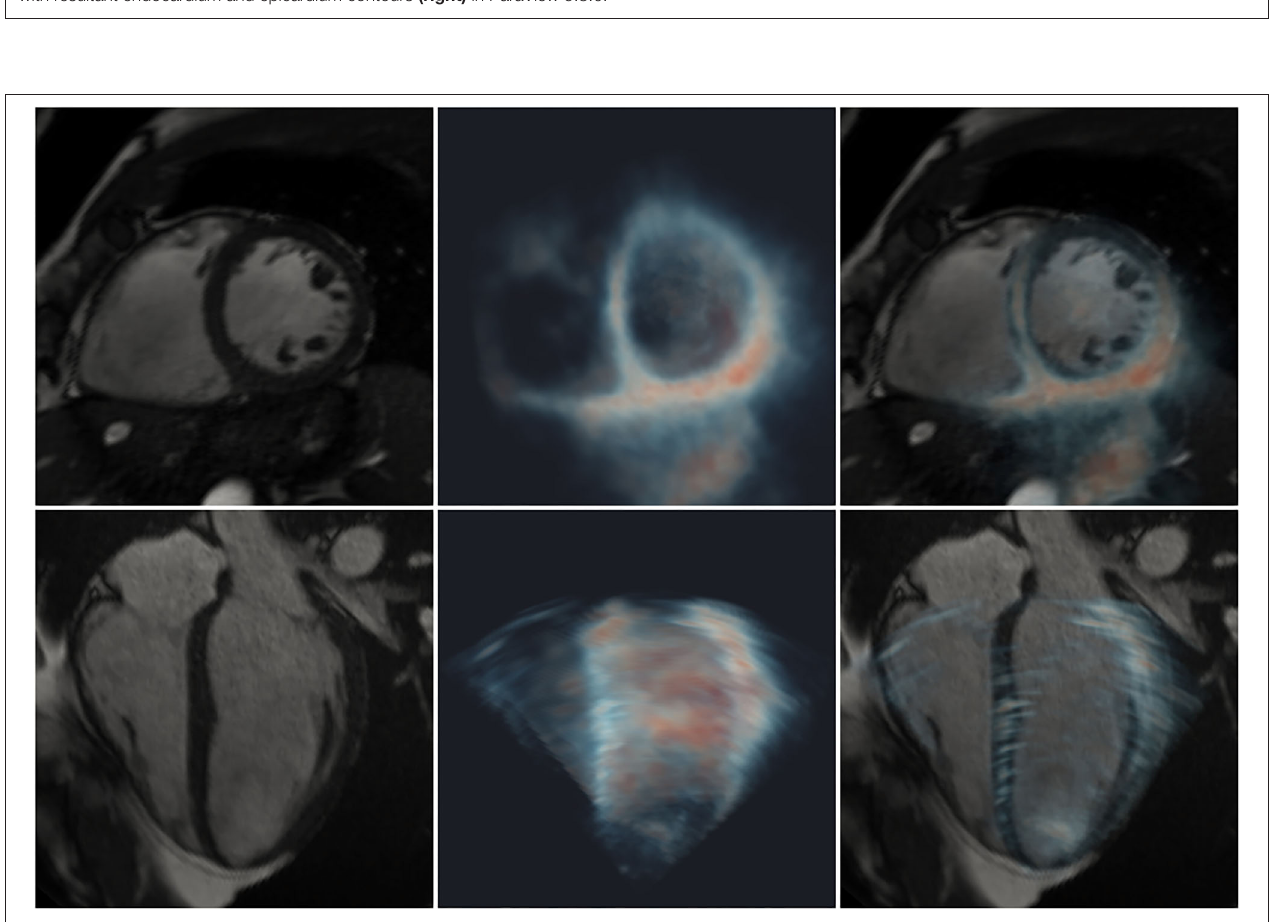
FIGURE 3 | Registration of 2D CMR images (greyscale) with a 3D-echo image volume (maximum intensity projection using blue-to-red colormap). Short- (top row) and long- (bottom row) axis views are shown. Left: CMR; middle: 3D-echo; right: fused CMR and 3D-echo.